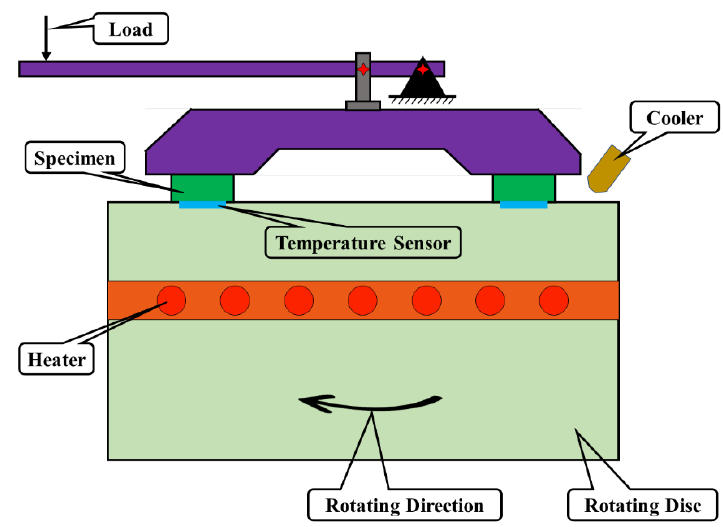
Figure 4. The schematic diagram of the JF150F-II Constant-Speed Tester.